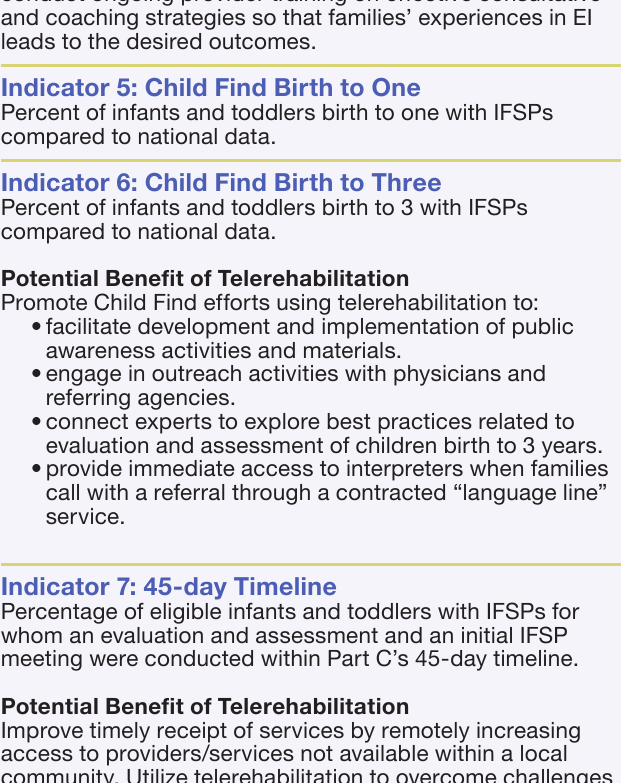
Selected OSEP Indicators and Potential Applications of Telerehabilitation